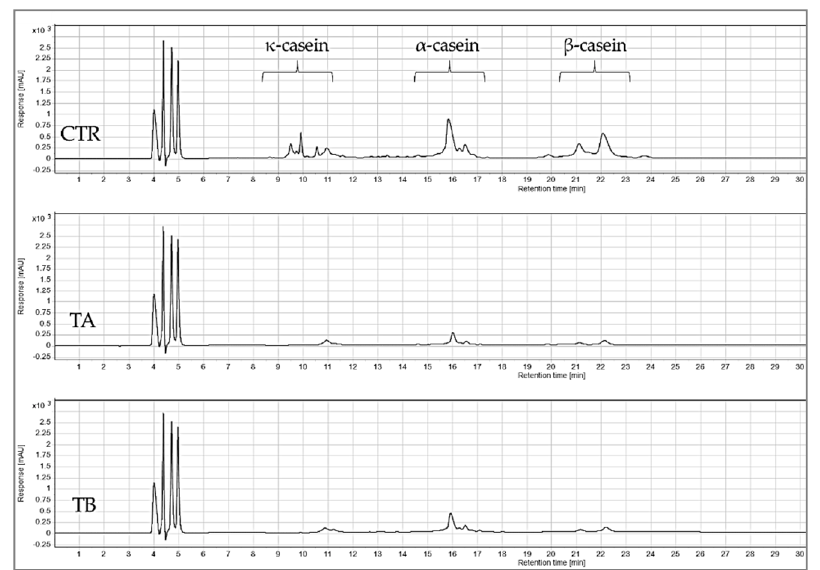
Figure 2. Chromatograms from reversed-phase high performance liquid chromatography analysis of mTG crosslinked micellar casein concentrate feed used in microfiltration. CTR: no enzyme treatment; TA: 5 °C/24 h; TB: 40 °C/90 min.